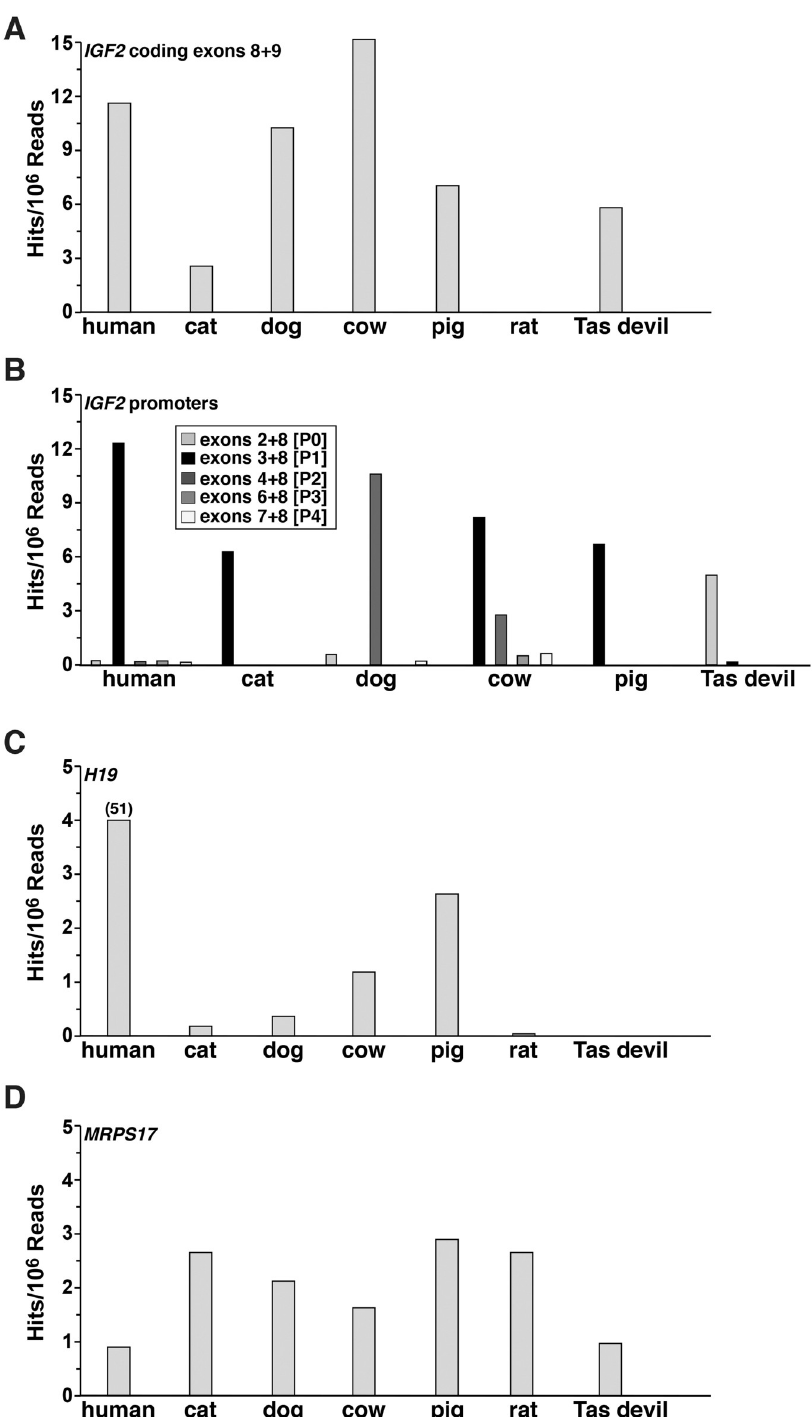
Fig 5. IGF2/Igf2 and H19 gene expression in mammals. Data on IGF2/Igf2 , H19 , and control gene MRPS17 / Mrps17 transcript expression in liver was obtained by screening RNA-sequencing libraries found in NCBI SRA (the libraries searched are listed in S1 Table, and the probes used in S2 Table). Results were graphed as hits identified per number of sequence reads in the library. A . IGF2/Igf2 mRNA levels were measured in human, cat, cow, dog, pig, rat, and Tasmanian (Tas) devil using probes containing coding exons that were equivalent to human exons 8 and 9 (see S2 Table). B . IGF2/Igf2 transcripts were assessed using probes containing each noncoding exon fused to the 5’ end of